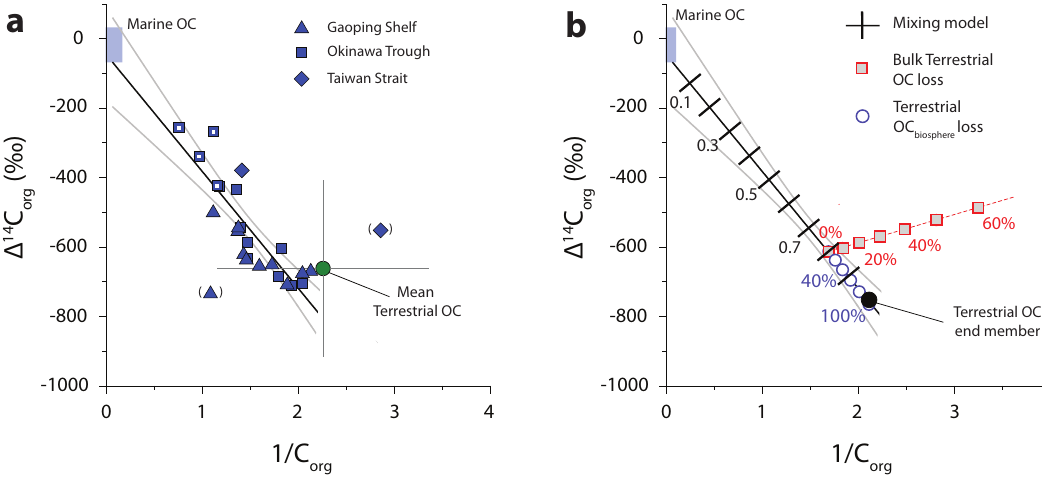
Figure 5. Radiocarbon contents of organic carbon (expressed as ∆ 14 C org , ‰) versus the inverse of OC concentration (1 / C org ) in marine sediments o ff shore Taiwan fed by dispersive terrestrial inputs (Fig. 1) with symbols as in Fig. 4. (a) All samples show a negative relationship between the variables ( r = − 0 . 6; P = 0 . 003) with a linear fit to all samples apart from those in brackets shown by the blank line ( r 2 = 0 . 7; P = 0 . 0001, grey line is the 95% confidence interval). (b) Linear relationship displayed in the samples along with the OC content predicted by (i) mixing marine OC and terrestrial OC (black line and dashes with fraction of terrestrial OC); (ii) loss of OC biosphere (starting at fraction terrestrial OC = 0.8, circles with % loss); and (iii) bulk terrestrial OC loss (squares with %